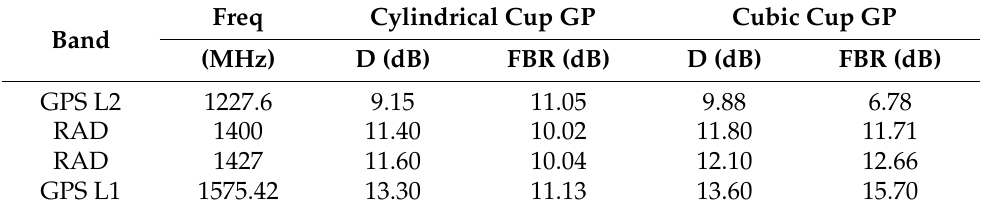
Table 6. Simulation results for Cylindrical Cup and Cubic Cup ground planes.